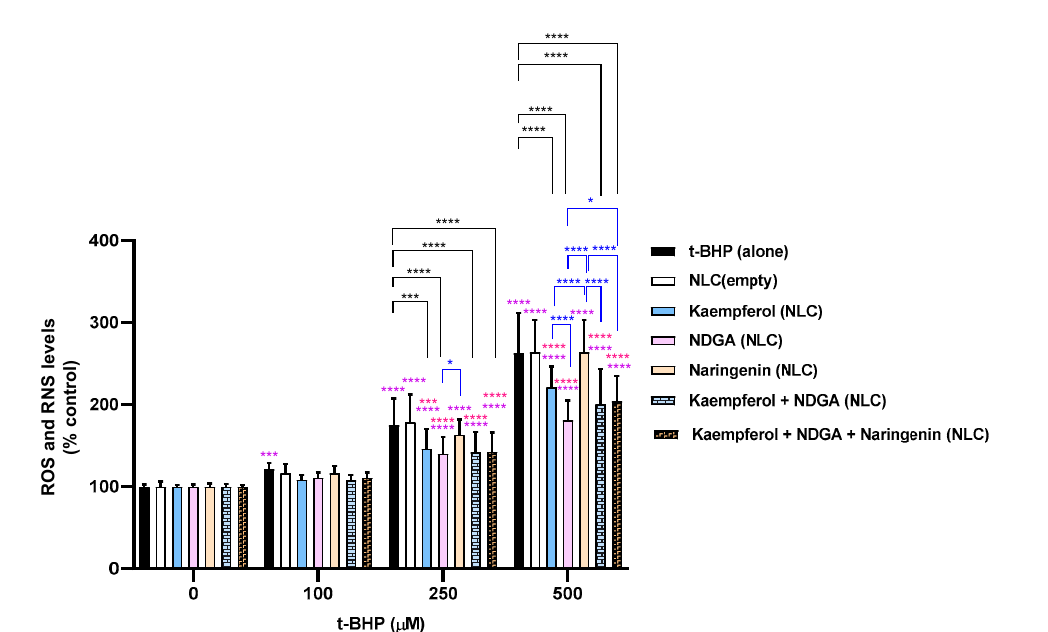
Figure 6. Intracellular levels of ROS/RNS 24 h after exposure to t-BHP (0–500 µ M) in the presence or absence of the developed NLC formulations. Results are expressed as Mean ± SD from 6 independent experiences, performed in triplicate. Statistical comparisons were made using Two-way ANOVA followed by the Tukey’s multiple comparisons test (* p < 0.05, *** p < 0.001; **** p < 0.0001; in purple the statistical analysis for each condition versus 0 μ M t-BHP is represented; in red the statistical analysis at each t-BHP concentration for the comparison between NC-loaded NLC formulations and unloaded NLC formulation is presented; in black the statistical analysis at each t-BHP concentration for the comparison between each NLC formulation and t-BHP alone is represented; in blue the statistical analysis at each t-BHP concentration for the comparison between the different NC-loaded NLC formulations is represented). In all cases, p -values < 0.05 were considered significant.